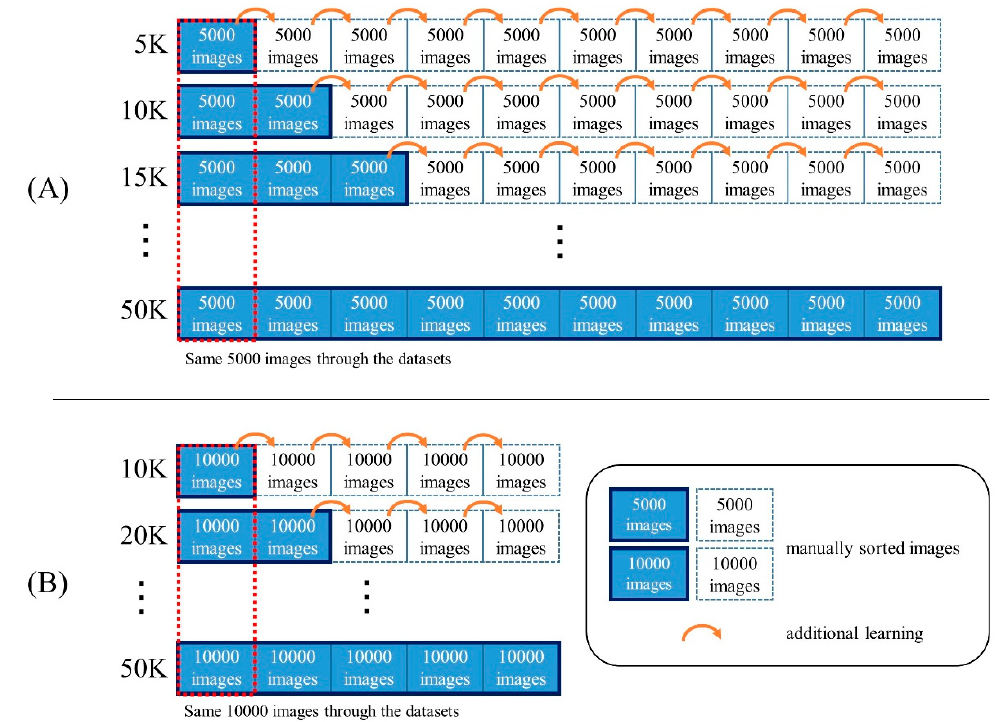
Figure 2 . Outline of the training performed for creating the models. Additional learning for every ( A ) 5000 images ( B ) 10,000 images.